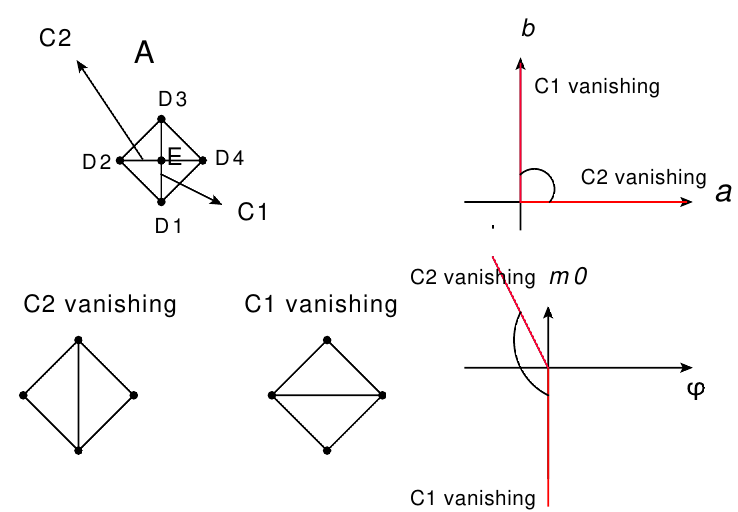
Figure 6 . Left: the crepant resolution of toric diagram A in figure 5 and two partial resolutions where we have a gauge theory description. Right: up is the Nef cone with basis of divisors D 1 and D 2 ; lower is the cone using the basis E and − D 1